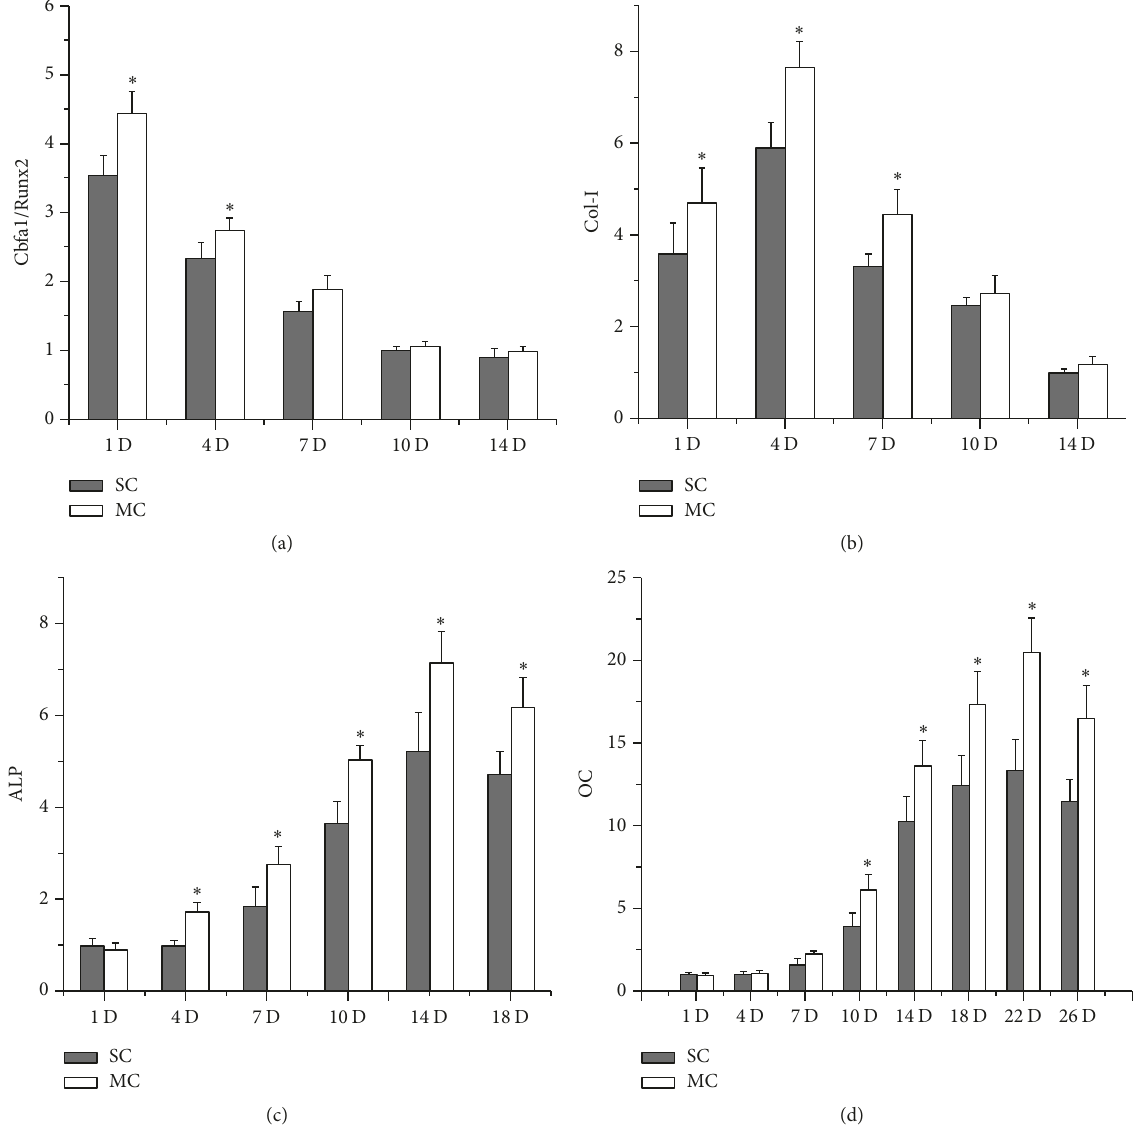
Figure 3: Effect of microvibration on osteogenic gene expressions in BMSC cellular scaffolds. Cbfa1/Runx2, Col I, ALP, and OC mRNA expressions were assayed on days 1, 4, 7, 10, 14, 18, 22, and 26. Data show that microvibration greatly upregulated these mRNA levels at different stages of osteogenesis. Each bar represents the mean ± standard deviation ( 𝑛 = 3 ); ∗ 𝑃 < 0.05 . SC, static culture. MC, microvibration culture. Col I, collagen I. ALP, alkaline phosphatase. OC, osteocalcin. From Zhou et al., [17] with kind permission from eCM journal